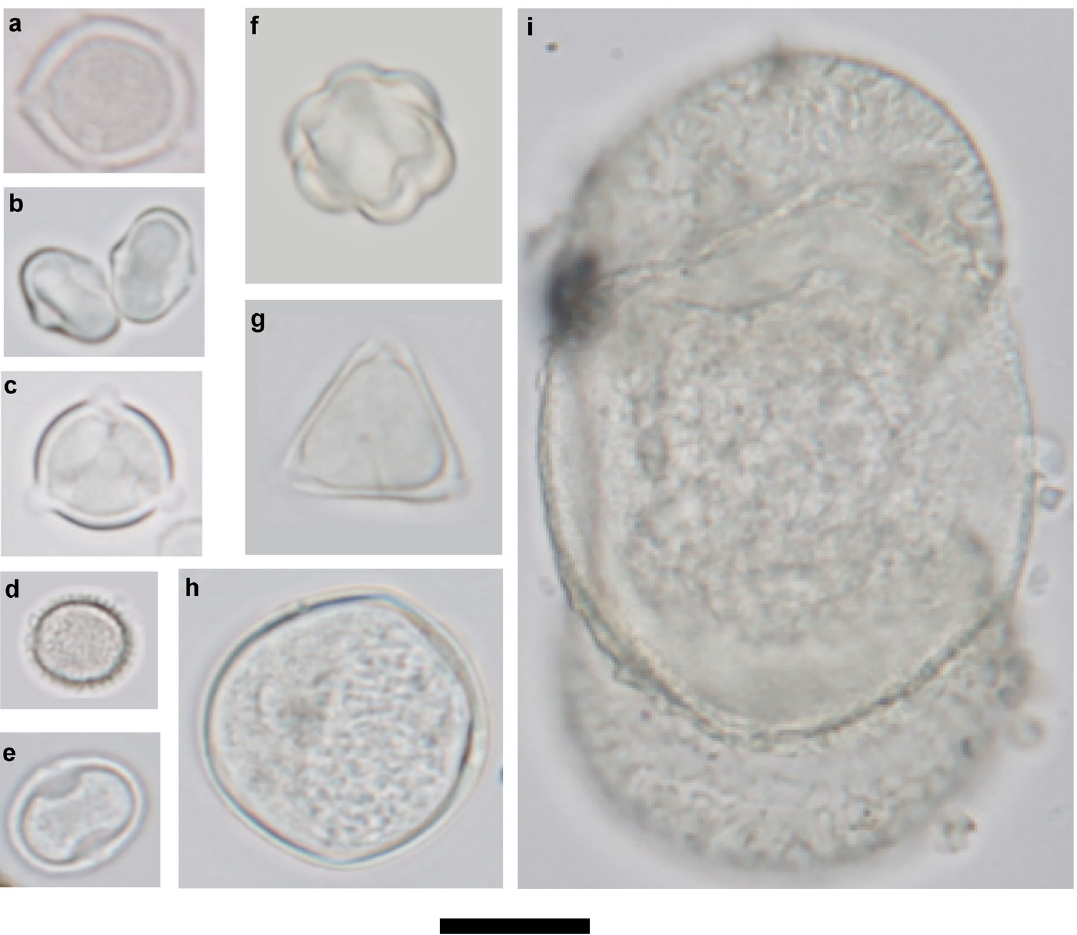
Fig. 3 Images of common pollen grains sampled at the different heights over the rainforest and identi fi ed up to family level. a Oleaceae, b Fabaceae, c Euphorbiaceae, d Asteraceae, e Moraceae, f Meliaceae, g Sapindaceae, h Poaceae, and i Podocarpaceae. Scale bar: 20